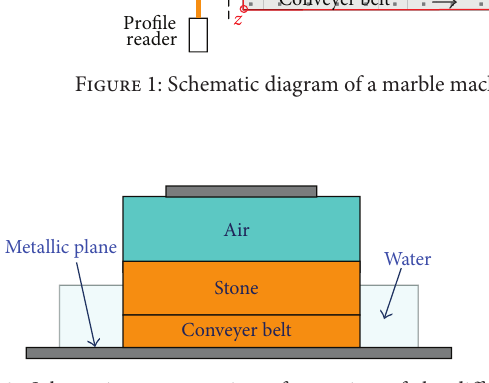
F 2: Schematic representation of a section of the different materials/parts inside the